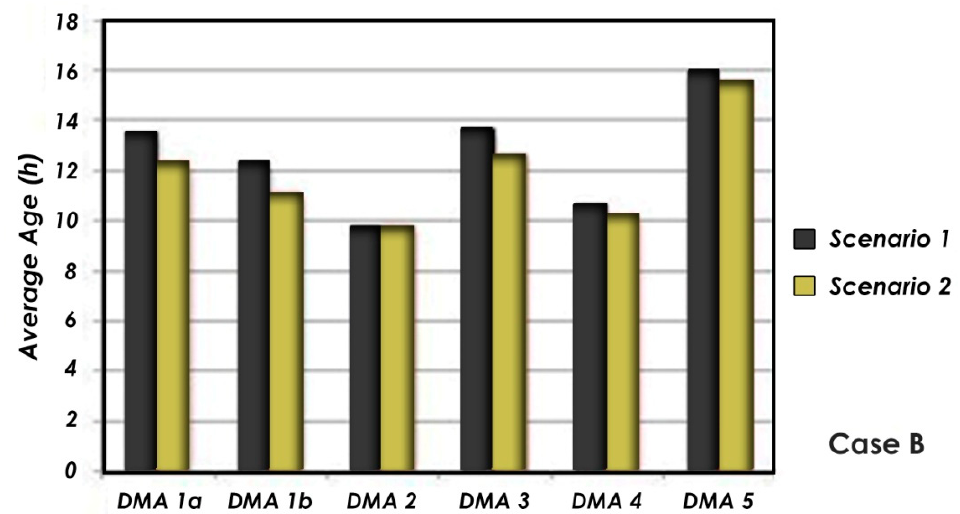
Figure 12. Average Age of water for Scenario 1 and 2 in case B.